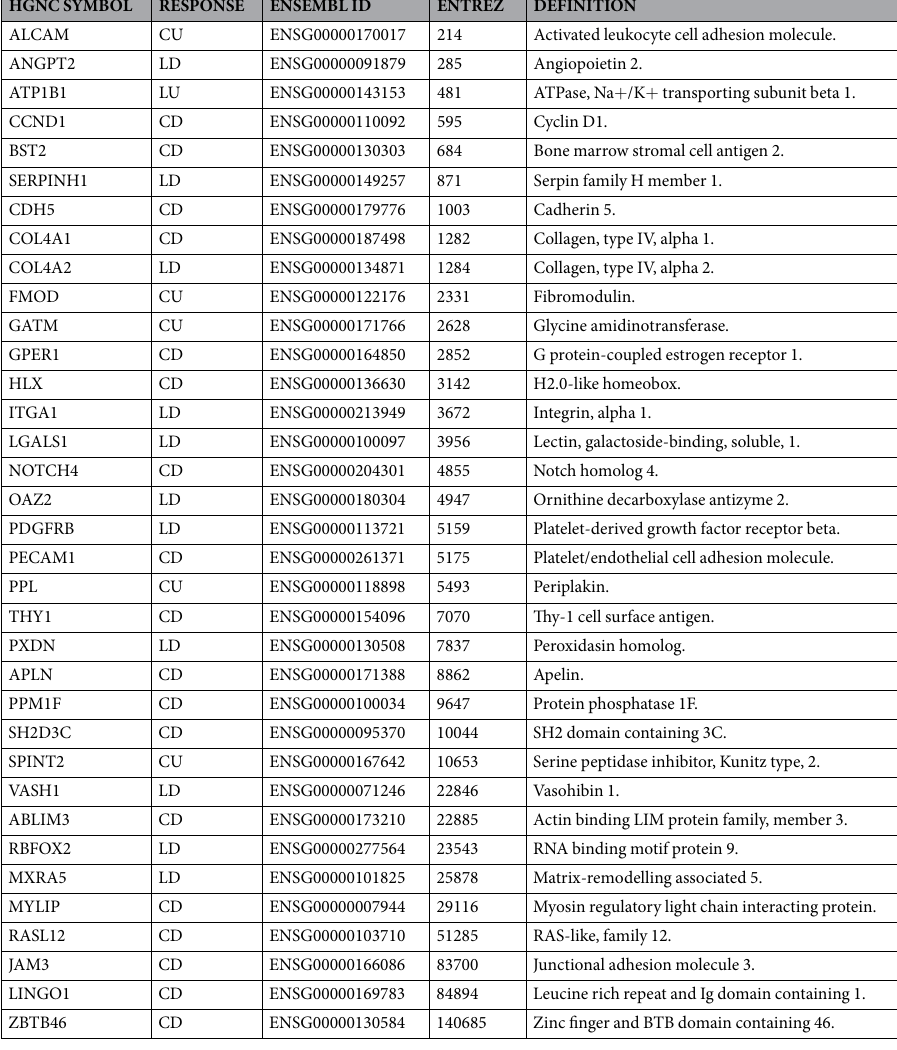
Table 1. Proliferating Transcriptome Core List. Codes for response are: (LD) linear decreasing, (LI) linear increasing, (CD) nonlinear concave down, and (CU) nonlinear concave